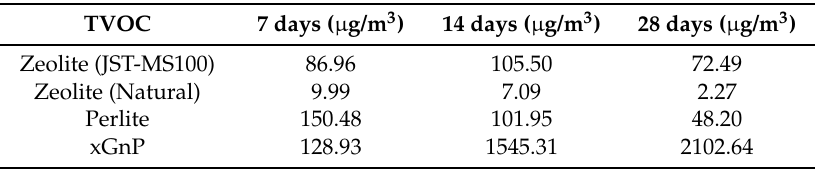
Figure 4. Xylene adsorption amount of xGnP. Table 3. Sustainability evaluation of adsorption performance.